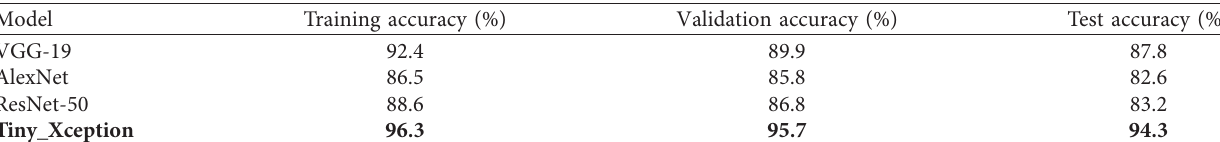
Figure 19: Deconvolution Table 4: Comparison between different models.